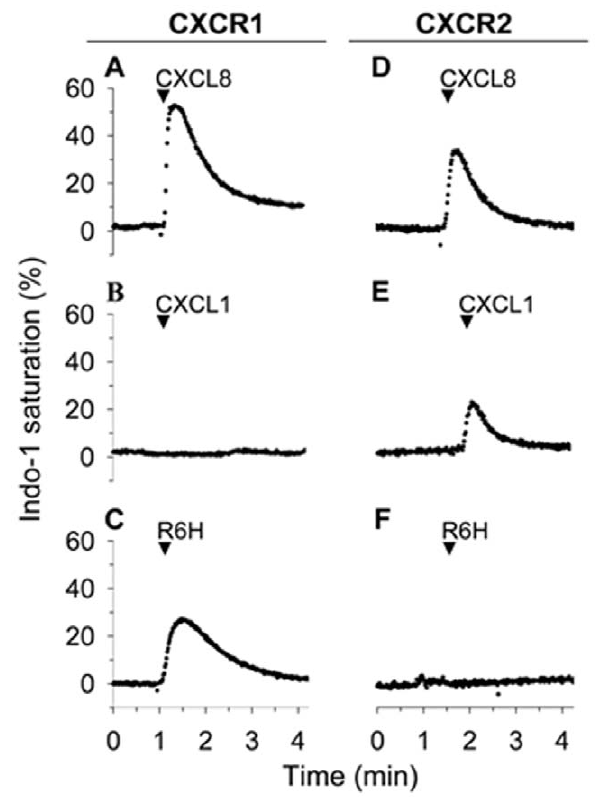
Figure 1. The R6H-CXCL8 mutant triggered calcium responses in HL-60 cells expressing CXCR1. HL-60 cells expressing CXCR1 or CXCR2 loaded with Indo-1 were stimulated with 100 nM of CXCL8, CXCL1 or R6H-CXCL8 mutant. The percentages of intracellular calcium responses are estimated from the calcium signal elicited by permea- bilization of the cells with the detergent dodecylmaltoside (referred as 100%). The record is representative of at least five independent